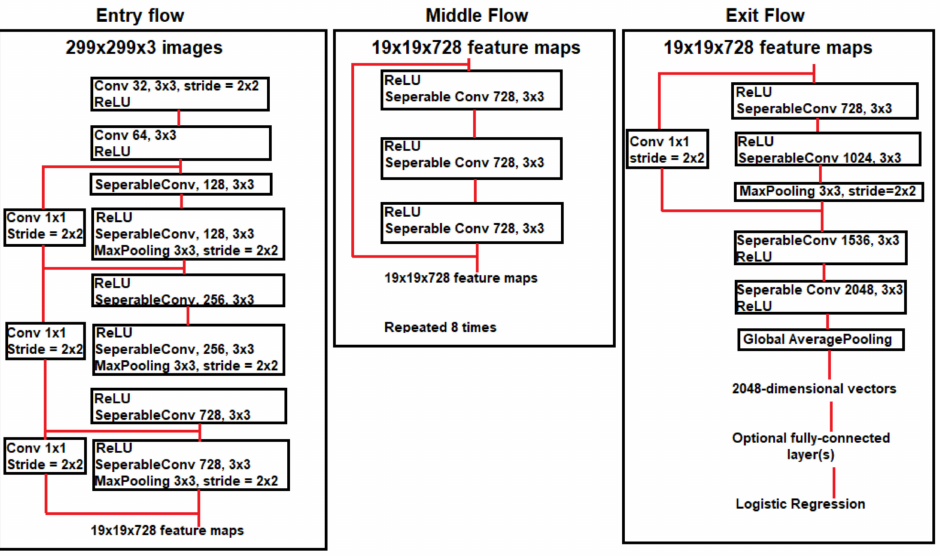
Figure 4. Xception recreation, based on the original image found in